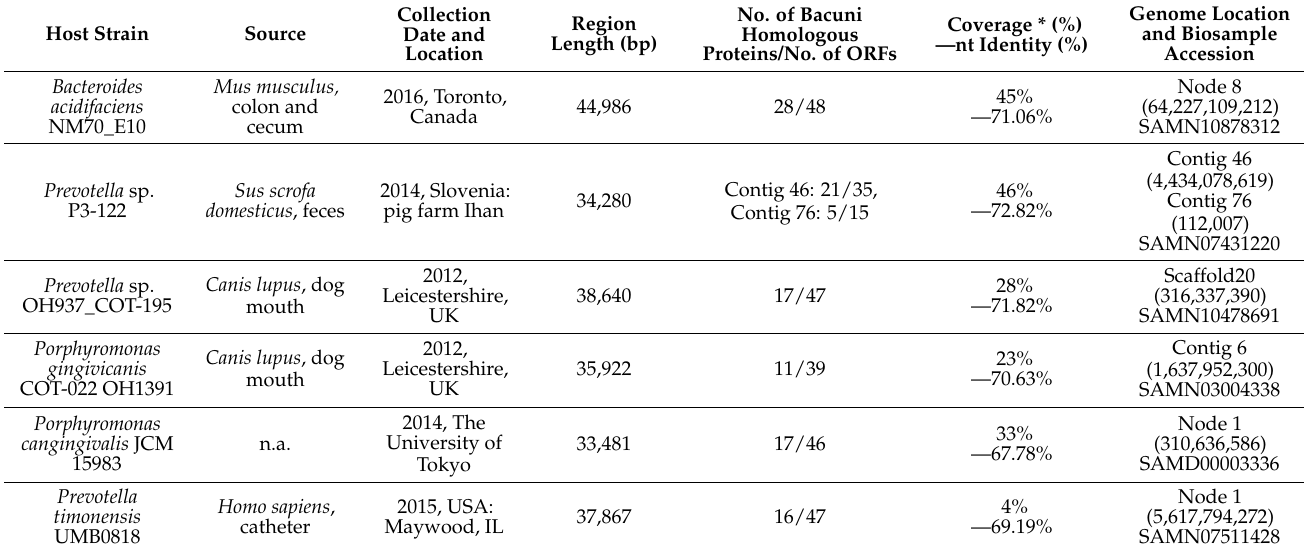
Table 2. Comparison of selected genome characteristics between Bacuni phages and putative partially homologues prophage